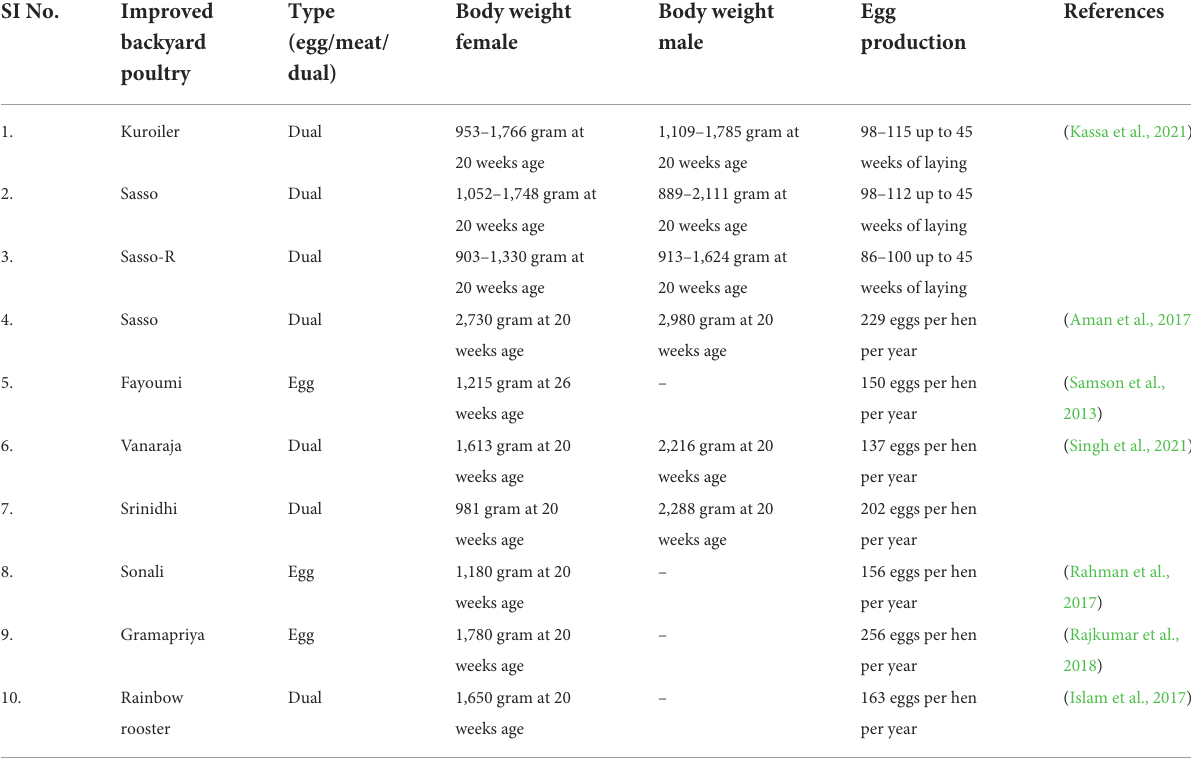
TABLE 1 Growth and egg production performance of improved backyard poultry germplasm. SI